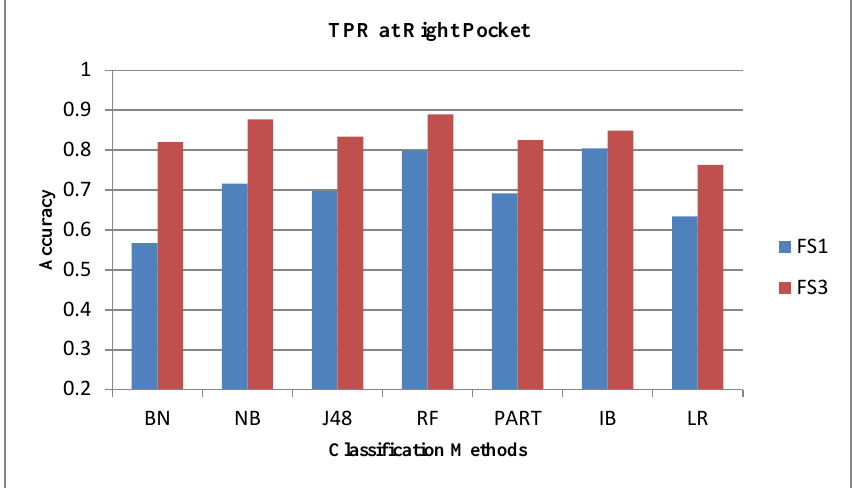
Figure 6. The magnetometer performance for the walking